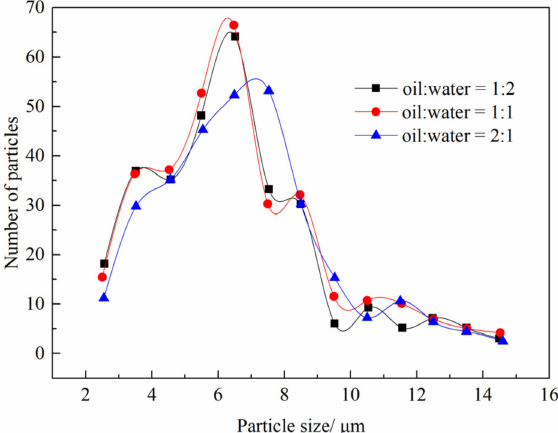
Figure 15. Relationship between the emulsion size distribution and the oil–water